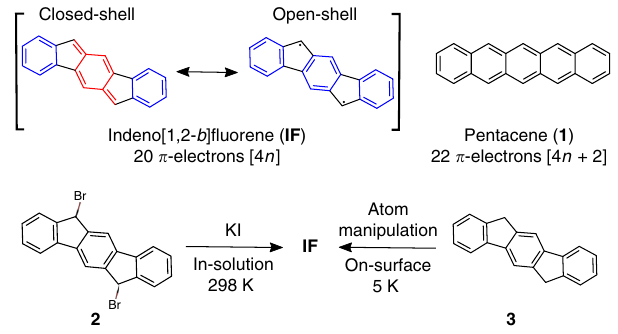
Fig. 1 Molecular structures of indeno[1,2- b ] fl uorene ( IF ) and related compounds. The central eight π -electron para -quinodimethane core of IF is shown in red, the six π -electron Clar sextets are shown in blue